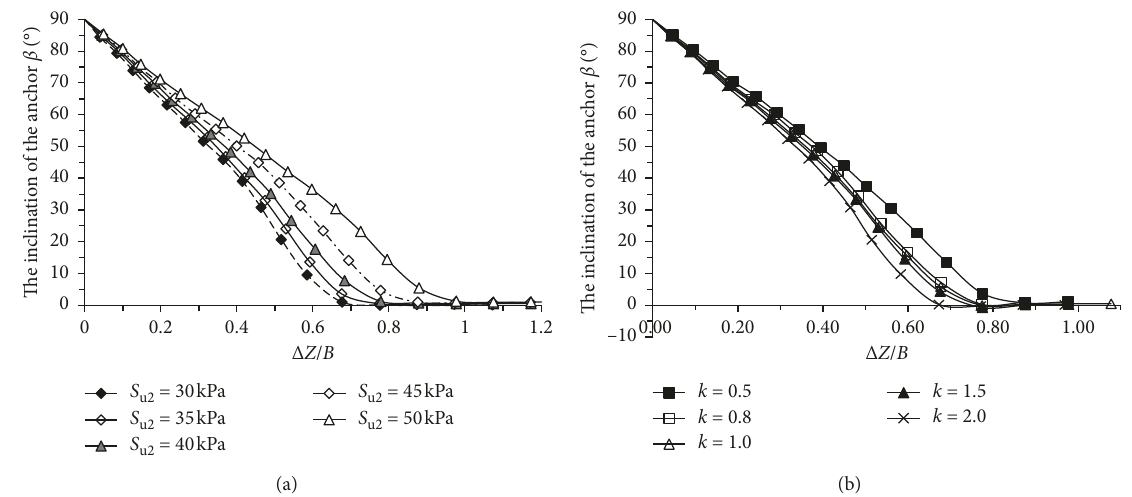
Figure 13: The effect of soil strength on the keying process of plate anchors: (a) effect of the soil strength of middle stiff soil layer; (b) effect of the strength gradient of top soil